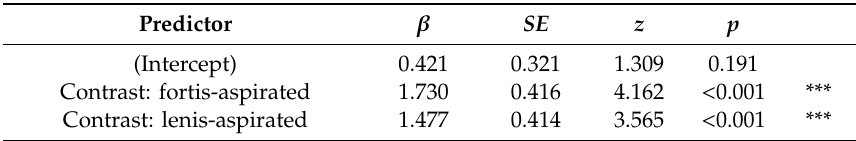
e ff ect of Category [ χ 2 (2) = 13.770, p < 0.01], of Group [ χ 2 (2) = 8.564, p < 0.05], and of the Category ×